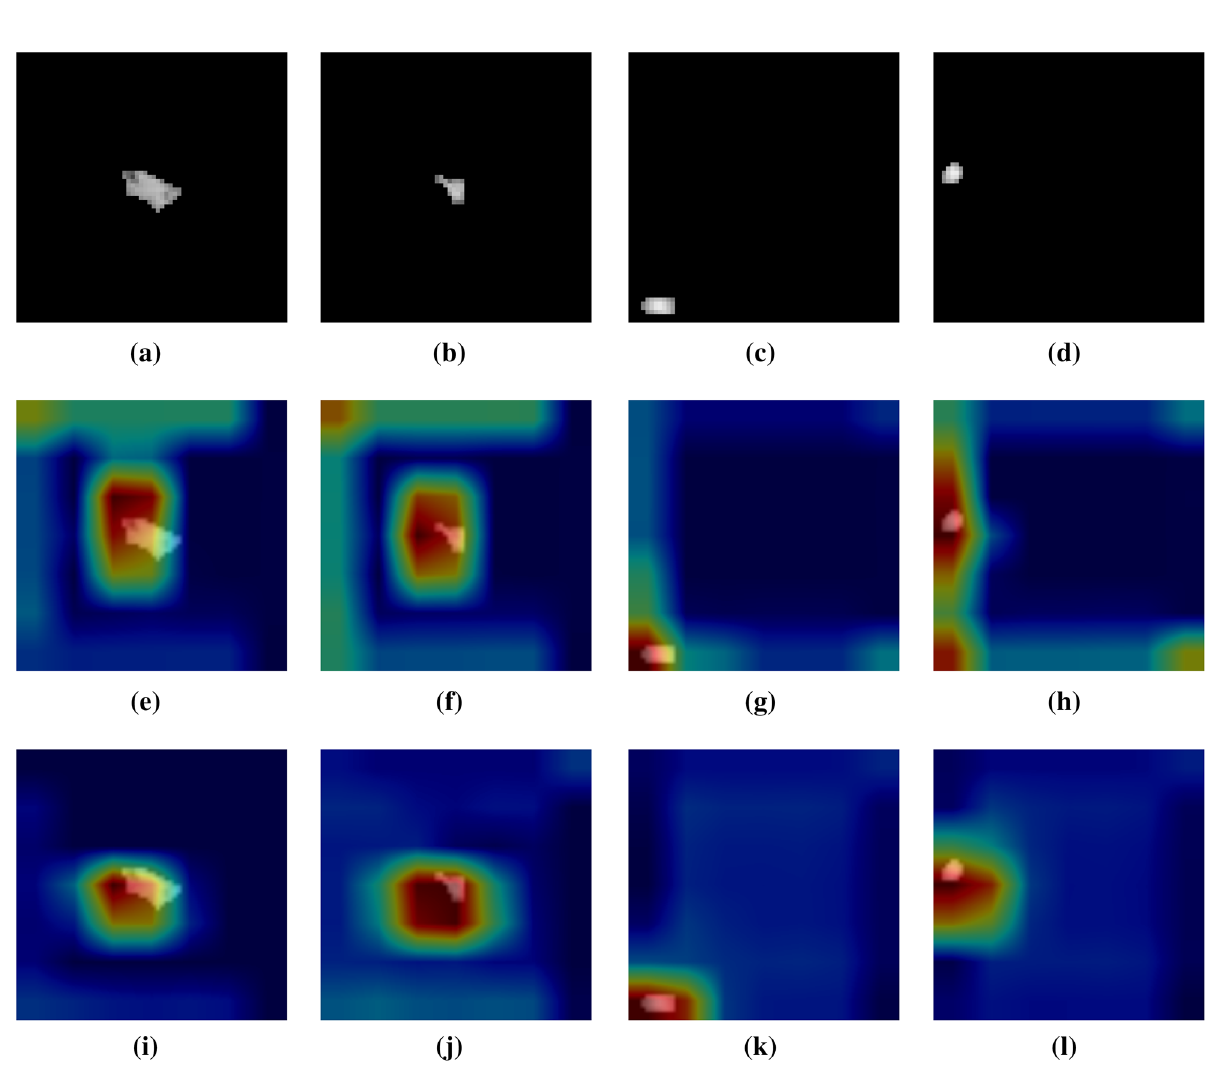
Figure 6. The Grad-CAM maps. ( a )–( d ) Preprocessed sample image. ( e )–( h ) Corresponding AE-VGG16 image. ( i )–( l ) Corresponding AE-VGG19